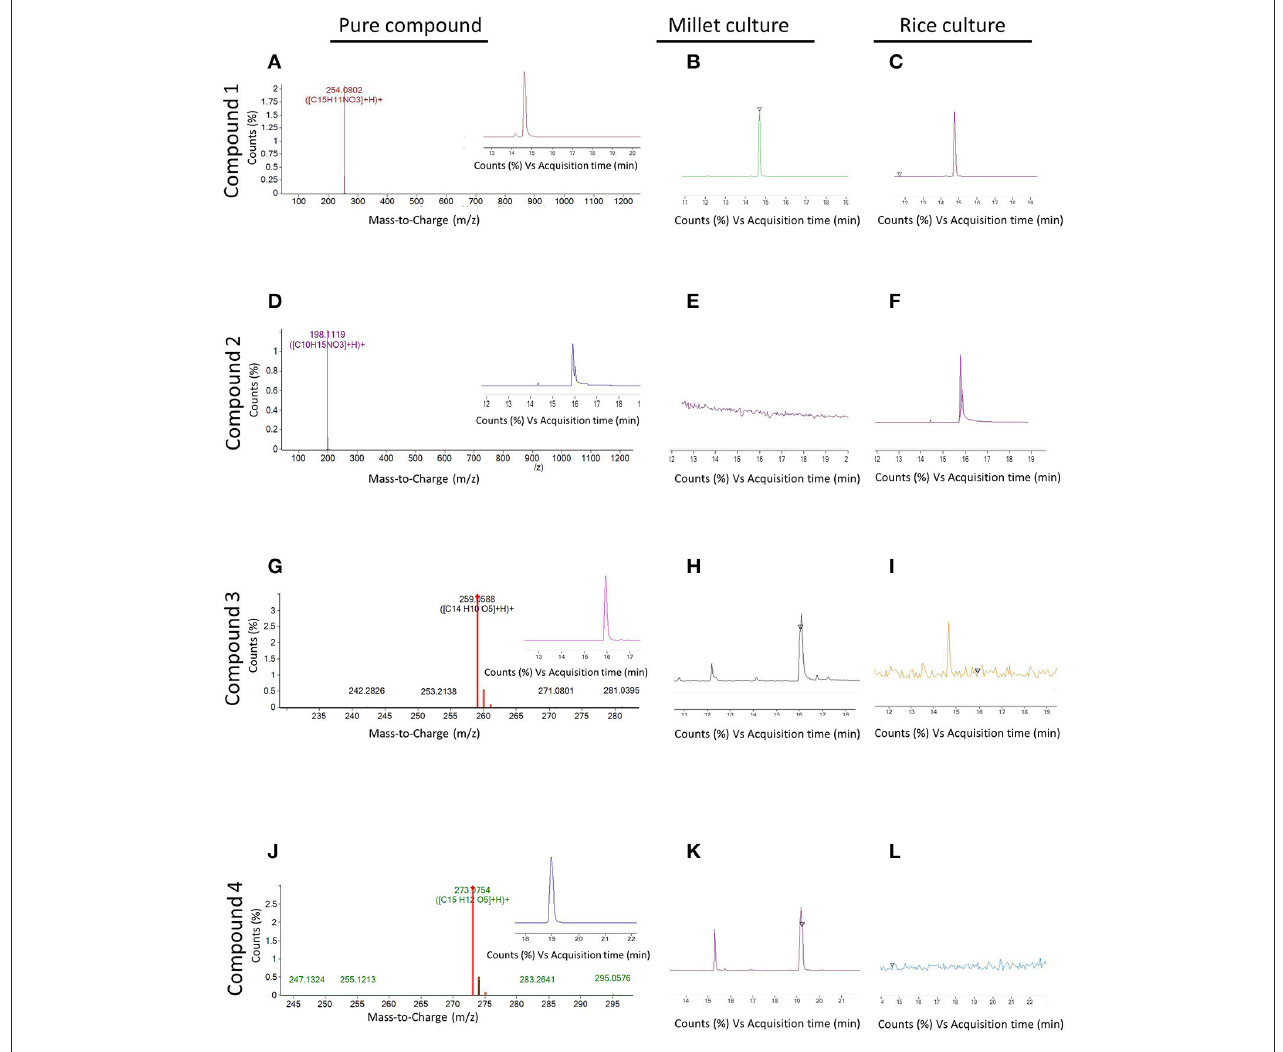
FIGURE 5 | Mass spectroscopy of peaks with antifungal activity detected in extracts from endophyte WF4. (A,D,G,J) (M+H + ) values of compounds 1, 2, 3, and 4 respectively. The insets show the retention time of each respective compound. (B,E,H,K) Magnification within the whole spectrum of the extract of WF4 cultured on millet medium, showing the absence or presence of peaks corresponding to compounds 1, 2, 3, and 4 respectively. (C,F,I,L) Magnification within the whole spectrum of the extract of WF4 cultured on rice medium, showing the absence or presence of peaks corresponding to compounds 1, 2, 3, and 4 respectively.